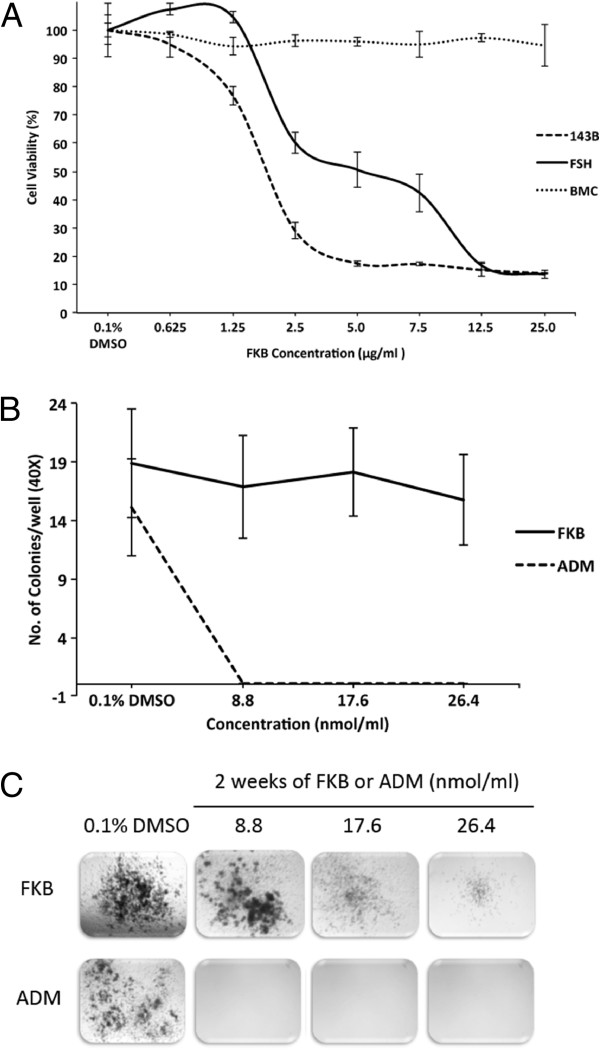
FKB showed preferential inhibition on 143B cells compared with FHS and bone marrow stem cells. A, FKB treatment exhibited differential effects on 143B OS cells, normal small intestinal epithelial cell (FHS) and bone marrow stem cells. Cells were treated with FKB for 72 h. B, Compared with Adriamycin, FKB showed significantly less bone marrow inhibition effect. C, Representative microphotography, taken at 14 days after treatment of bone marrow stem cell colonies showed the size of a typical colony decreased with a higher concentration of FKB.